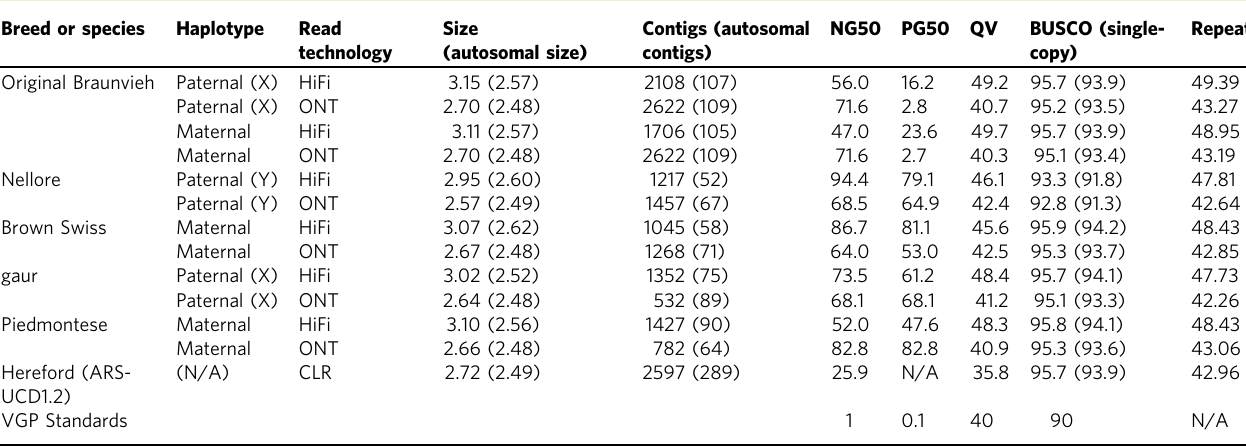
The assembly haplotype is either maternal or paternal (indicating either an “ X ” or “ Y ” paternal sex chromosome). The ARS-UCD1.2 reference is not haplotype-resolved and lacks suf fi cient parental data to assess phasing, hence the N/A. Size and contigs refer to the entire genome assembly, while the autosomal values only measure chromosomes 1 through 29. NG50 is the contig N50 using the ARS- UCD1.2 reference sequence as the expected length. PG50 is NG50 after splitting contigs into haplotype-phased blocks. Phasing and QV are determined through merqury using parental and F1 short reads. Scaffolded NG50 is not shown, as all assemblies are effectively end-to-end (excluding centromeres and telomeres), with values greater than 100Mb. Assemblies are available online 107